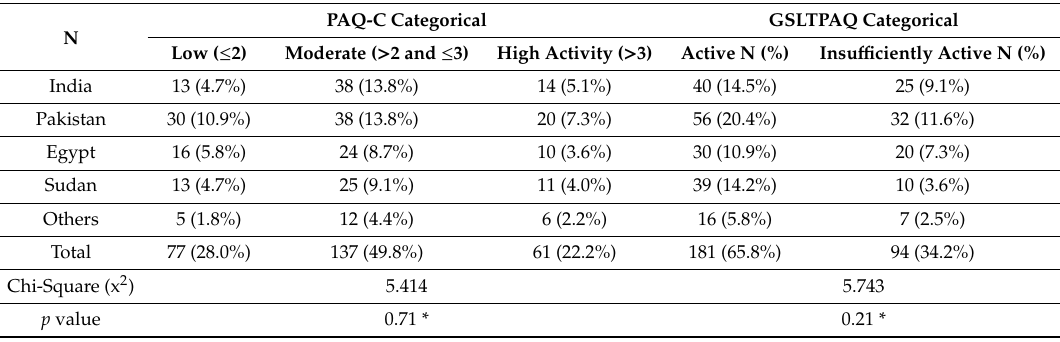
Table 3. Physical activity levels categorized by Physical Activity Questionnaire for Older Children